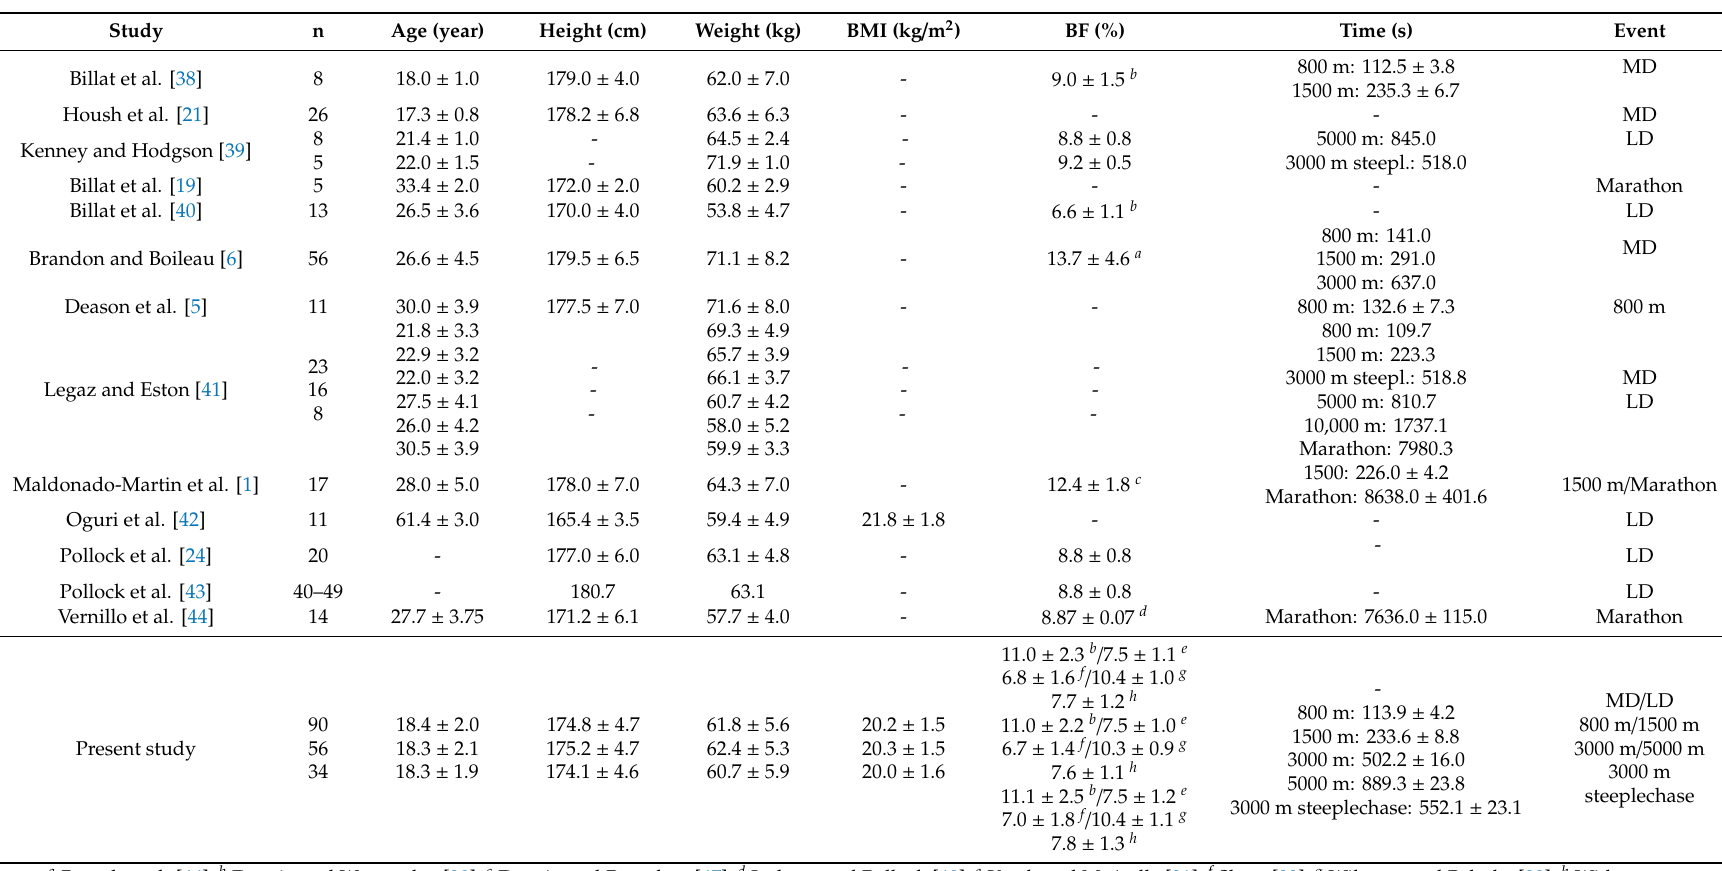
Table 4. Summary table of studies examining age, height, weight, BMI, %BF and performance of elite runners participating in di ff erent events (mean ± SD).